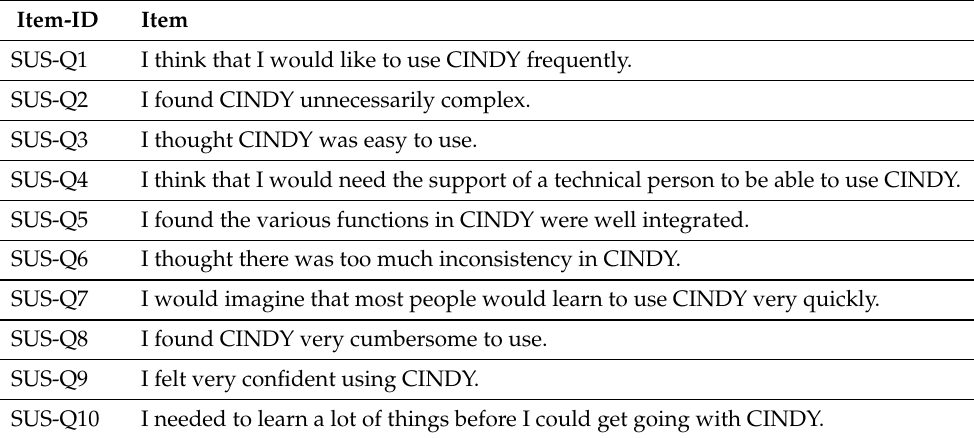
Table 2. SUS Questionnaire proposed in this study (English